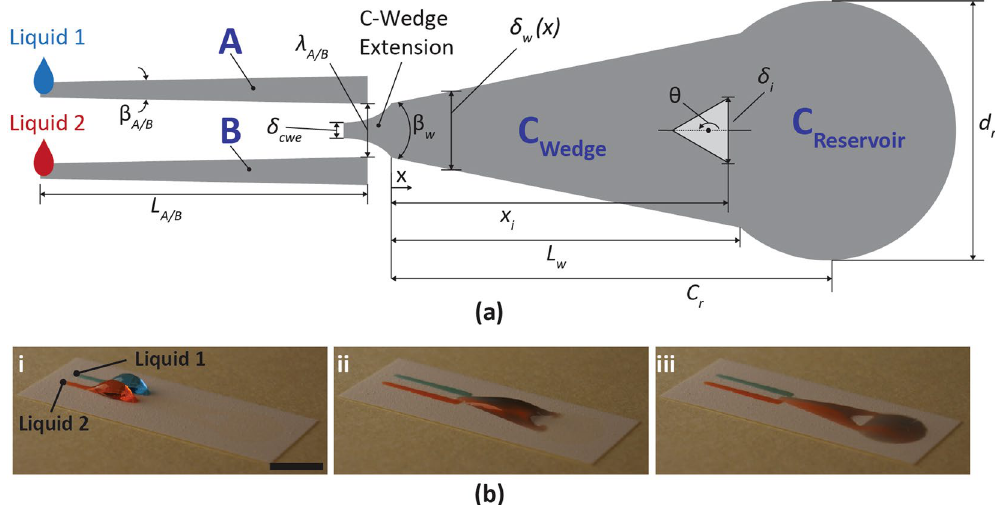
Figure 1. ( a ) Schematic depiction of the basic SDSM configuration studied herein. The superhydrophobic island within C wedge can be square, circular or triangular with different orientation angles ( θ = 0 to 180°). In general, δ i was taken at the widest part of the island (for details see Fig. S1 of the SI). ( b ) Representative images of a tested SDSM: (i) before, (ii) during, and (iii) after mixing of two liquids. To show the concept, dyed water droplets (Liquid 1 and Liquid 2) were dispensed in tracks A and B. The scale bar in (i) denotes 1 cm, and applies to all images in ( b ). For more details on the mixing process, see video SM1 of the